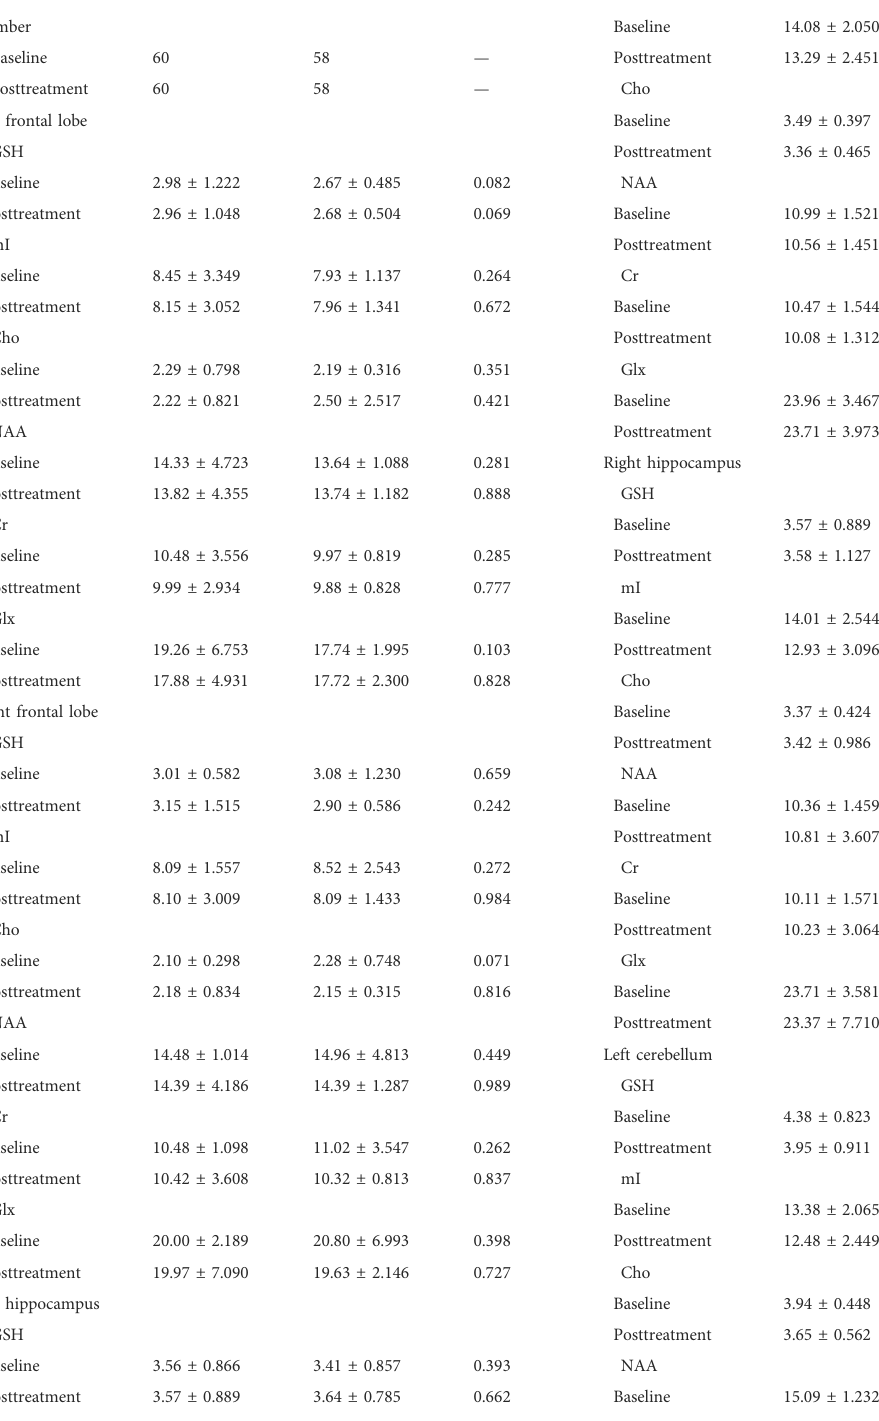
TABLE 4 Analysis and comparison of 1 H-MRS in the participants at baseline and posttreatment between the JTW and placebo groups. Placebo JTW p Value